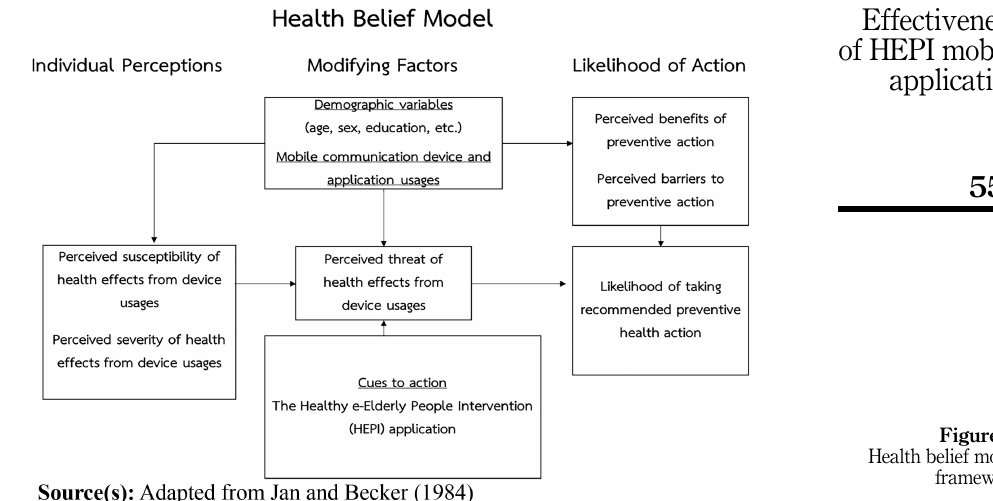
Figure 1. Health belief